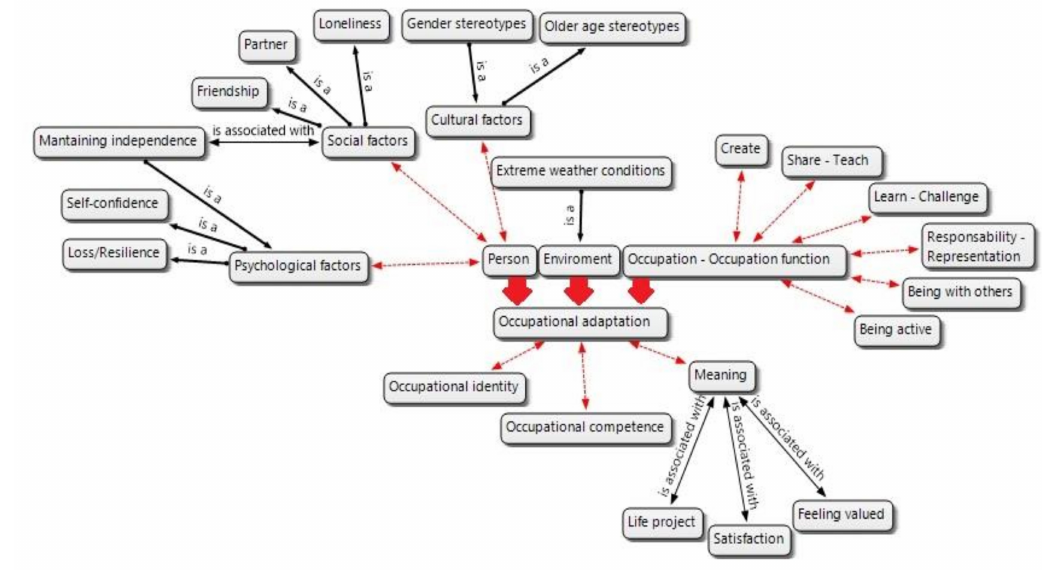
Figure 1. General map of codes and